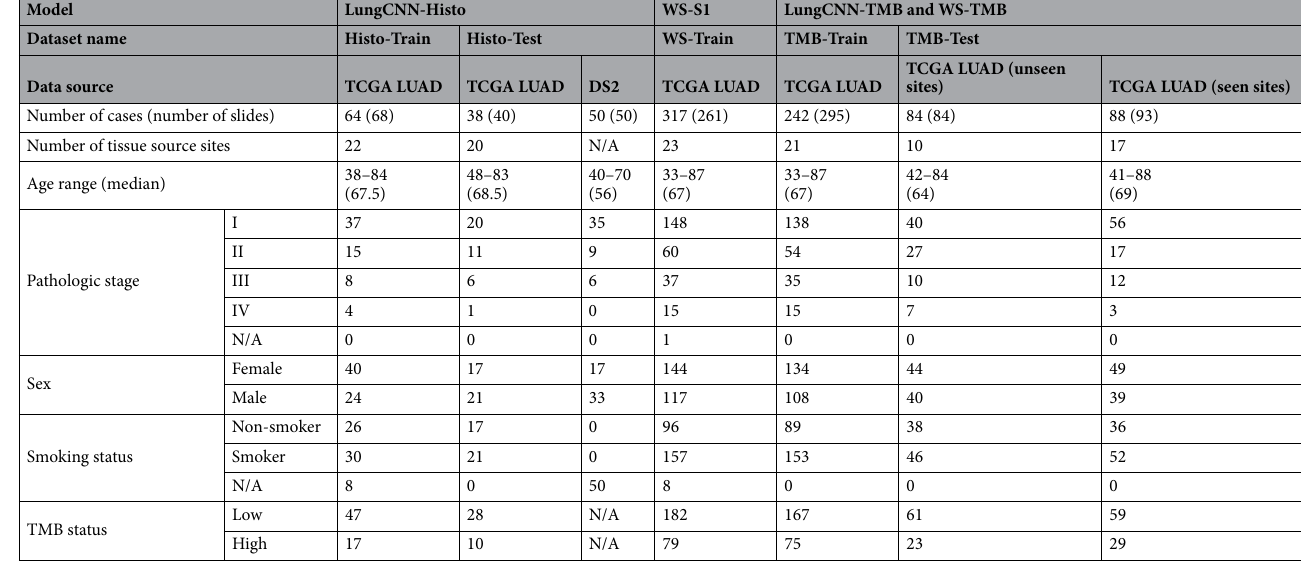
Table 1. Summary of data used for training and testing the LungCNN-Histo and the TMB classification